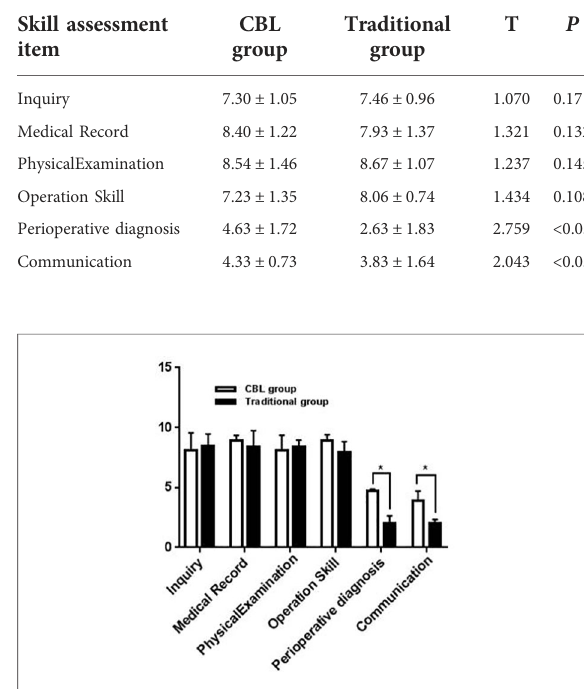
FIGURE 3 Average scores of various indicators of skill